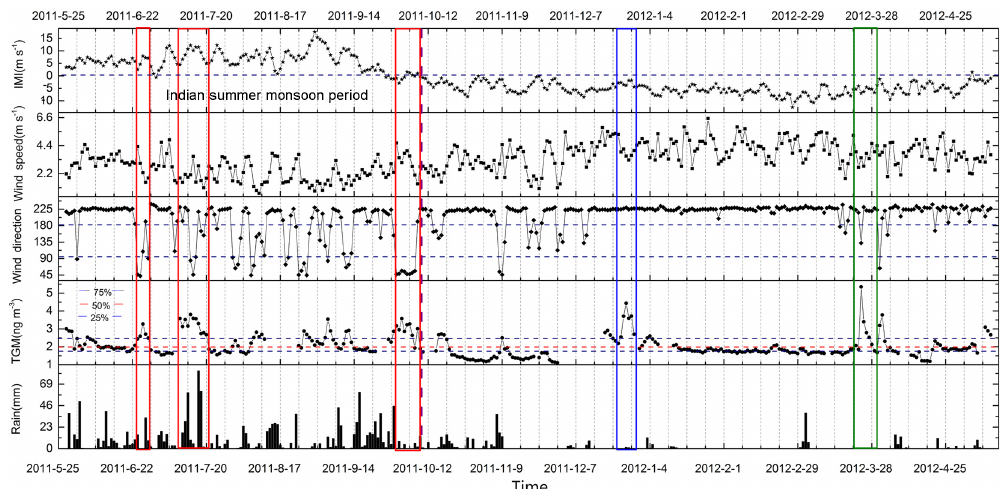
Figure 8. The distribution of the Indian monsoon index (IMI), TGM and rainfall at ALS. IMI displays that the ISM period was from May to September. RF events mainly appeared during the ISM period. Some high Hg events were accompanied by NE and east wind events during the ISM period. High TGM events were accompanied by the appearance of SW during the non-ISM